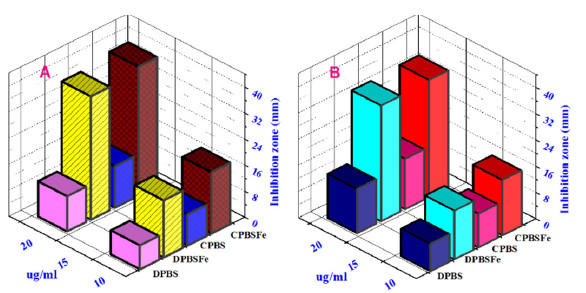
Figure 7. Antimicrobial efficacy for the compounds under investigation against ( A ) M. Luteus bac- teria and ( B ) C. Candidum fungi.